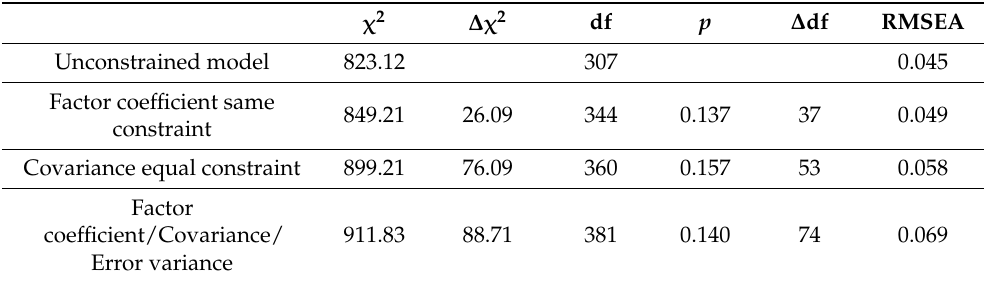
Table 15. Results of Verification of Measurement Equivalence by